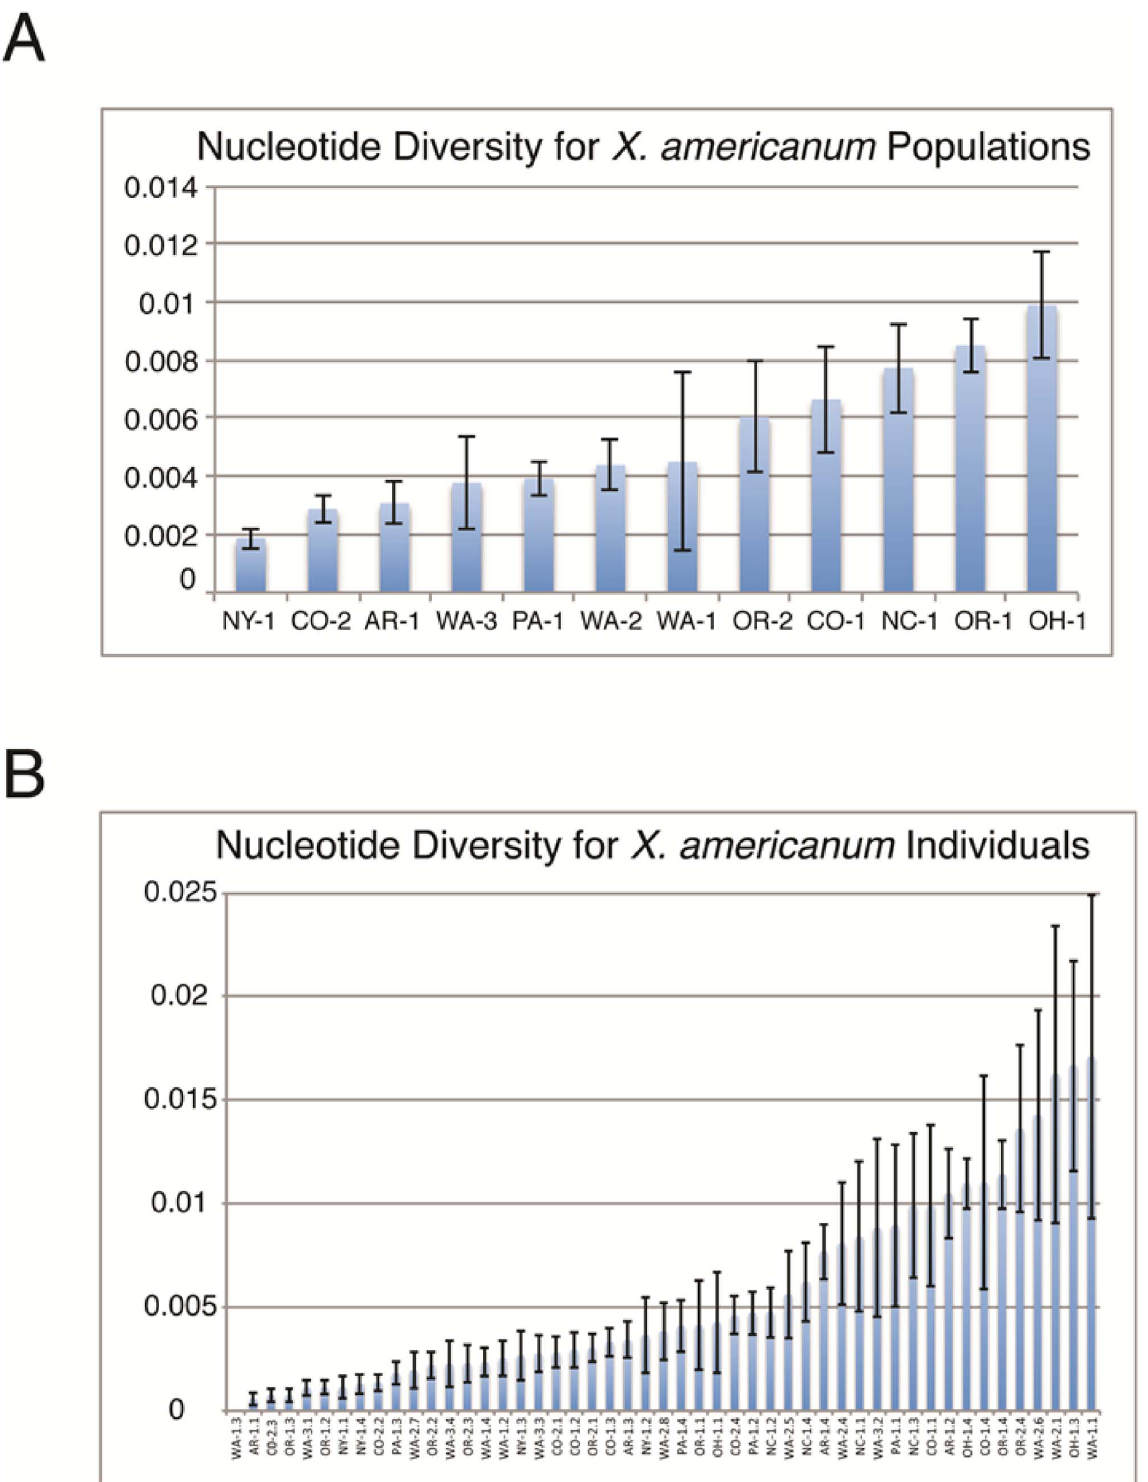
Figure 2. Nucleotide diversity ( p ) of ITS sequences from 12 populations of X. americanum (A) and 49 individual Xiphinema americanum (B) from North America. Error bars represent the standard deviation of p . Individual nematodes are indicated with a number following the population designation (e.g. WA-1.3 represents individual 3 from population WA-1). Note that the y-axes differ in scale from A (populations) to B (individuals).